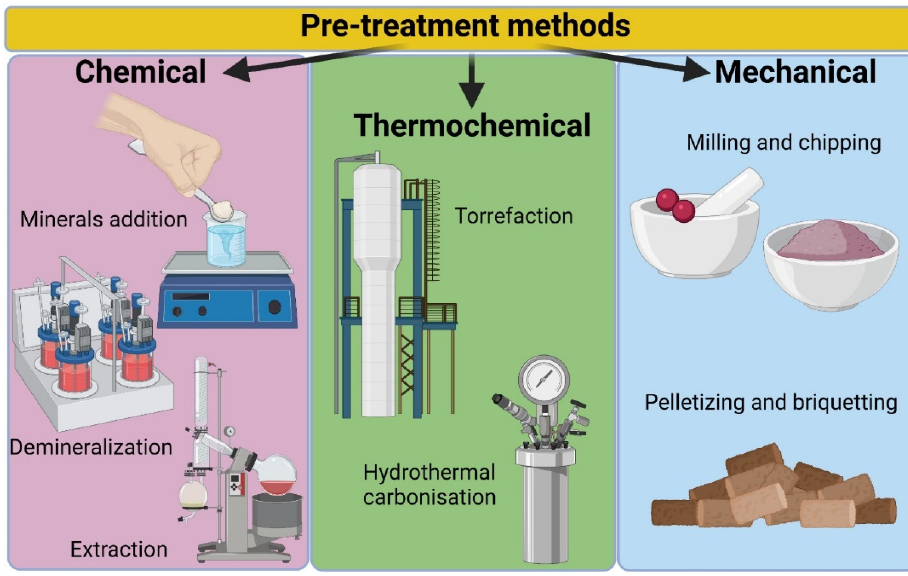
Figure 8. Pre-treatment methods which are related to the biomass gasification reactivity.